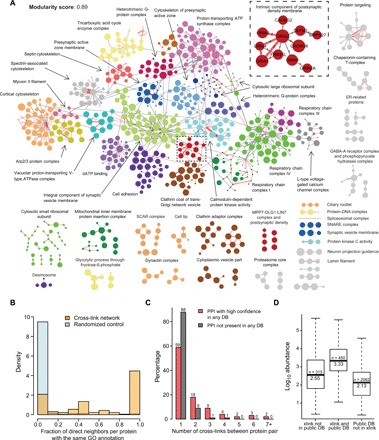
Characterization of XL-based protein interaction network.(A) Core component and separate modules of the combined network (dataset 1). Nodes represent proteins, and edges show the interactions identified by XL-MS. Nodes are color coded based on functional clusters generated by unsupervised edge-betweenness clustering and annotated by GO enrichment analysis. Disconnected modules were grouped using DAVID Gene Functional Classification, and each group was subsequently annotated. Edges in red indicate protein-protein interactions (PPIs) reported in the literature (high confidence in at least one database of STRING, InWEB, and BioGRID). Sizes of the nodes are proportional to the protein abundances (log2 scale). Widths of the edges are proportional to the number of unique Lys-Lys cross-links. Insert represents the enlarged cluster annotated as intrinsic component of postsynaptic density membrane, with the edges labeled according to the number of samples in which the PPI was identified. Network representations of individual experiments are provided in figs. S3 to S6. dATP, 2′-deoxyadenosine 5′-triphosphate. (B) Distribution of the number of cross-linked proteins pairs annotated within the same GO group in the XL-based network (labeled in orange) and a randomly rewired network (100 iterations, labeled in light blue). (C) Distribution of the number of cross-links found between protein pairs present in at least one database (DB) with high confidence (labeled in red) or not present in any of the three databases (i.e., STRING, InWEB, and BioGRID; labeled in black). (D) Boxplot showing the distribution of protein abundances in different categories: xlink, cross-linked proteins identified in this study; and public DB, protein interactions present in at least one public database with high confidence (i.e., STRING, InWEB, and BioGRID). The number of proteins and median abundance are indicated in each box. Protein abundance data were obtained from (12).